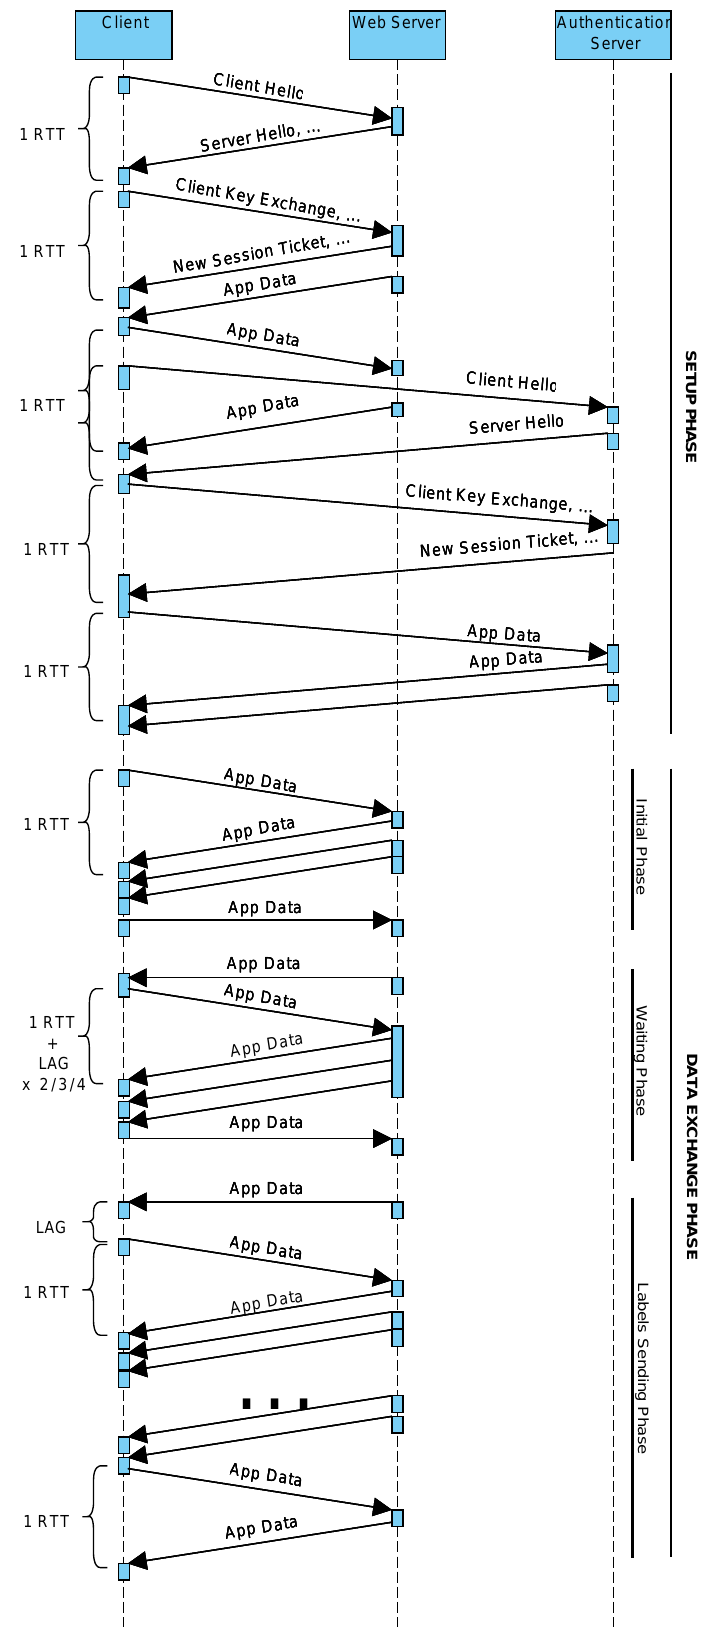
Figure 17. Sequence Diagram: API RTTs Analysis, setup